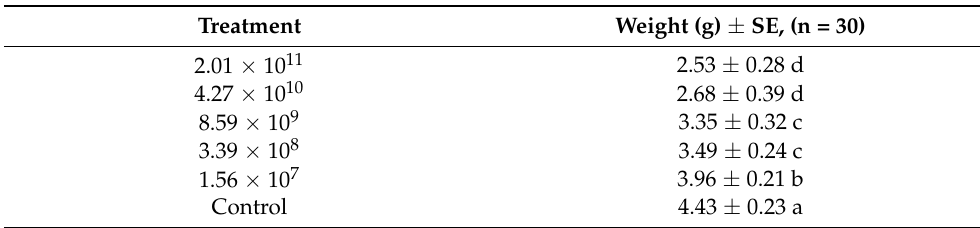
Table 4. The effects of Bacillus thuringiensis strain PDC-AHSAA1 concentrations on the weight of RPW larvae after 21 days of